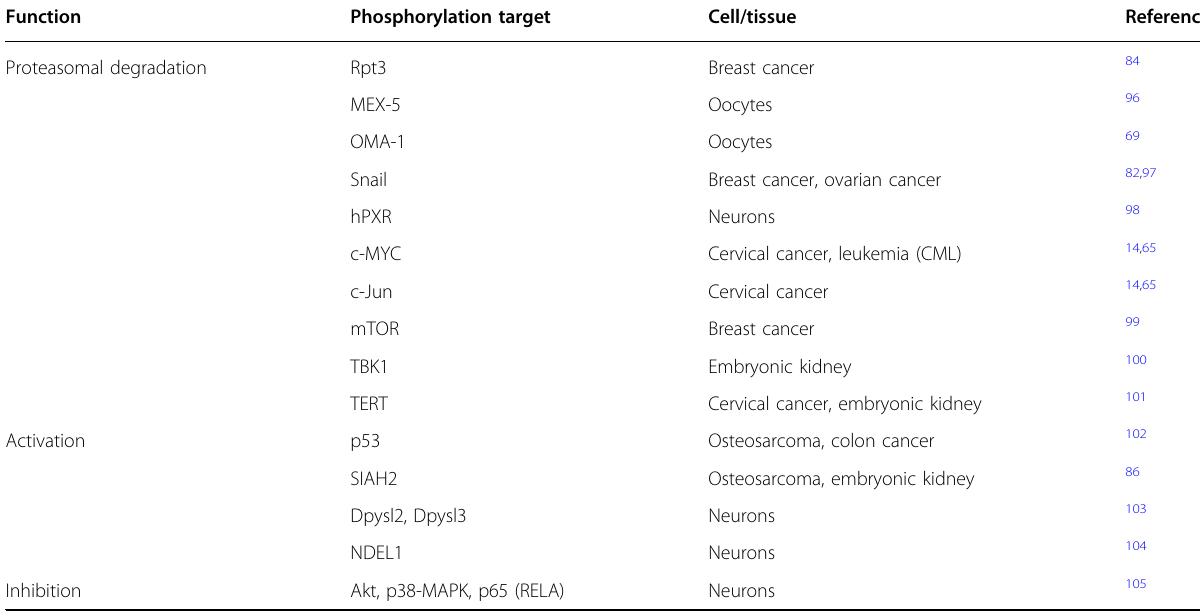
Table 2 Molecular targets of